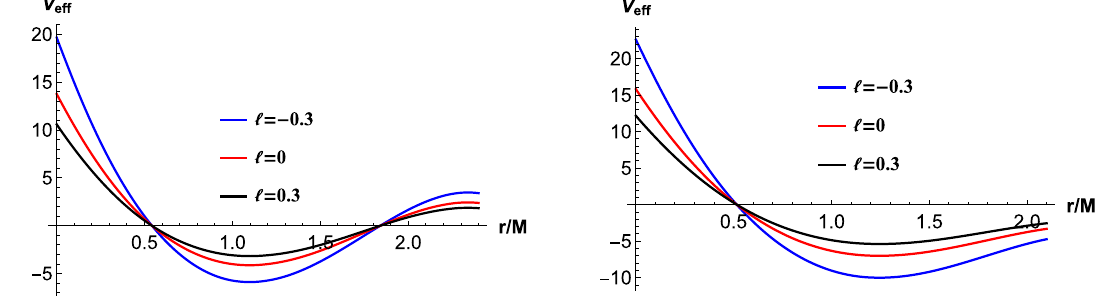
Fig. 13 The left panel describes the effective potential for prograde orbits and right panel describes the retrograde orbits for various values of (cid:2) with ˆ a = 0 . 1 M and b = 0 . 03 M 2